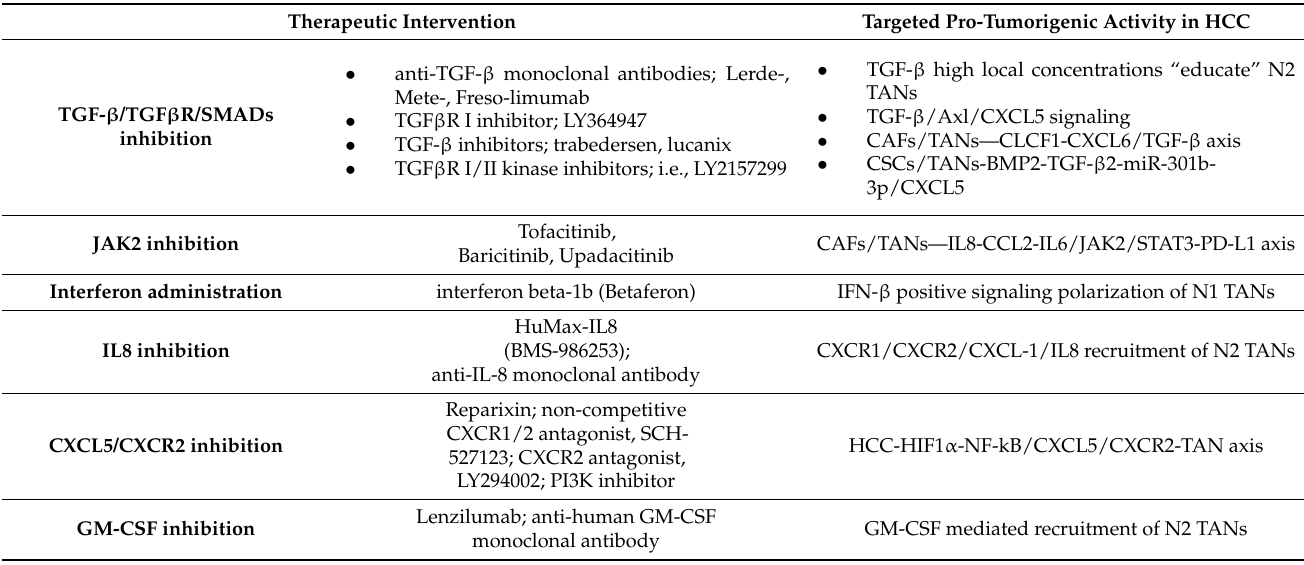
Table 4. Summary of potential therapeutic interventions and targets of TANs in HCC that may increase treatment efficacy in future